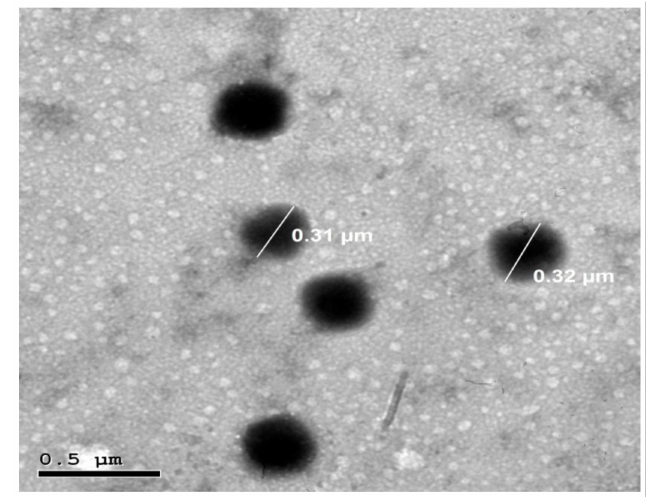
Figure 3. TEM photomicrograph of the best achieved chitosomal formulation (F6).